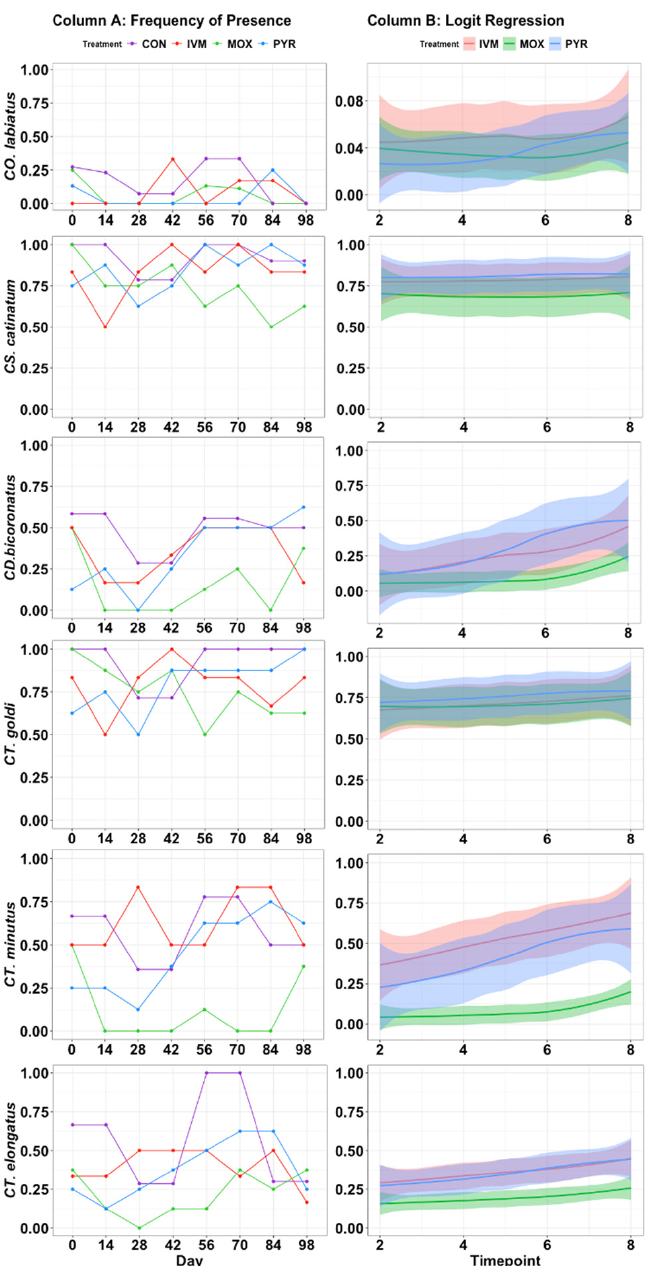
Figure 2. Frequency of presence and logit regression models of the multidrug-resistant species presence in the study herd. Column A contains frequency of presence at each time point, and column B contains the binomial logistic regression predicted probability of presence plots based on CON samples. Timepoint 2 = Day 14, Timepoint 3 = Day 28, Timepoint 4 = Day 42, Timepoint 5 = Day 56, Timepoint 6 = Day 70, Timepoint 7 = Day 84, Timepoint 8 = Day 98. Shaded areas indicate 95% confidence